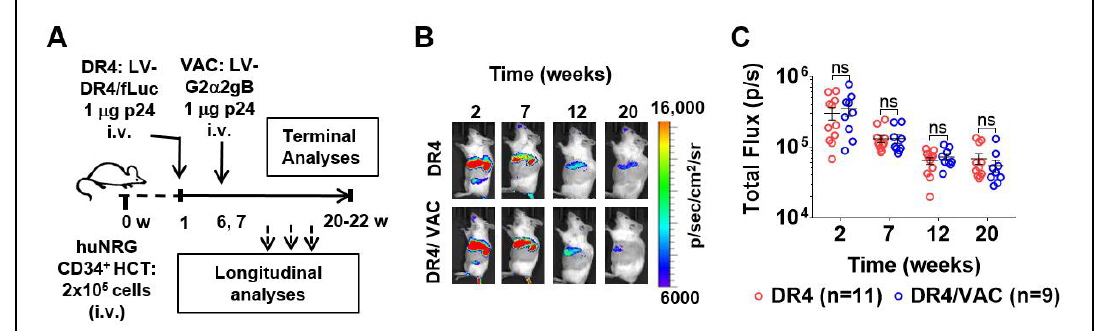
Figure 7. Administration of LV-DR4/fLuc vector (DR4, n = 11) and in combination with LV- G2α/gB ( DR4/VAC, n = 9) intravenously (i.v.) into huNRG mice and bioluminescence imaging (BLI) analyses. ( A ) Experimental design for testing the combined effect of DR4 and VAC in huNRG mice; ( B ) representative BLI picture of huNRG mice injected i.v. with 1 μ g p24 equivalents of LV-DR4/fLuc vector alone (DR4) or in a combination of 1 μ g p24 equivalents of LV- G2α/gB (DR4/VAC); ( C ) quantitative BLI signal obtained by quantifying ROI in spleen from each mouse in DR4 and DR4/VAC cohorts. Data pooled from four independent experiments. ns: not statistically significant; Statistical analyses were performed using the Welch t -test applied to log data